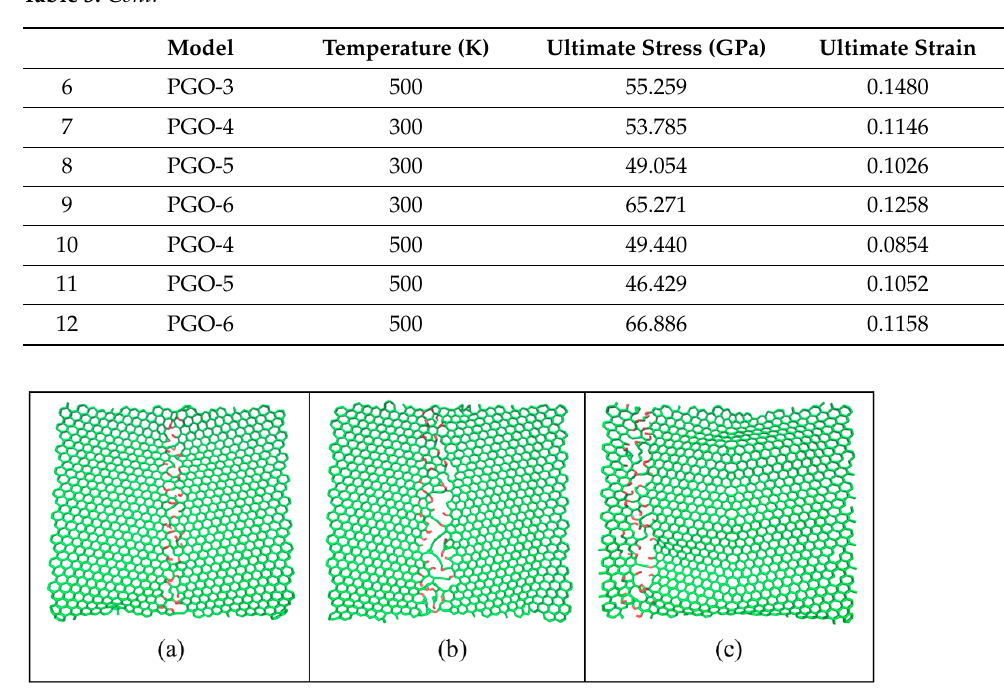
Table 3. Uniaxial tensile results using different models.